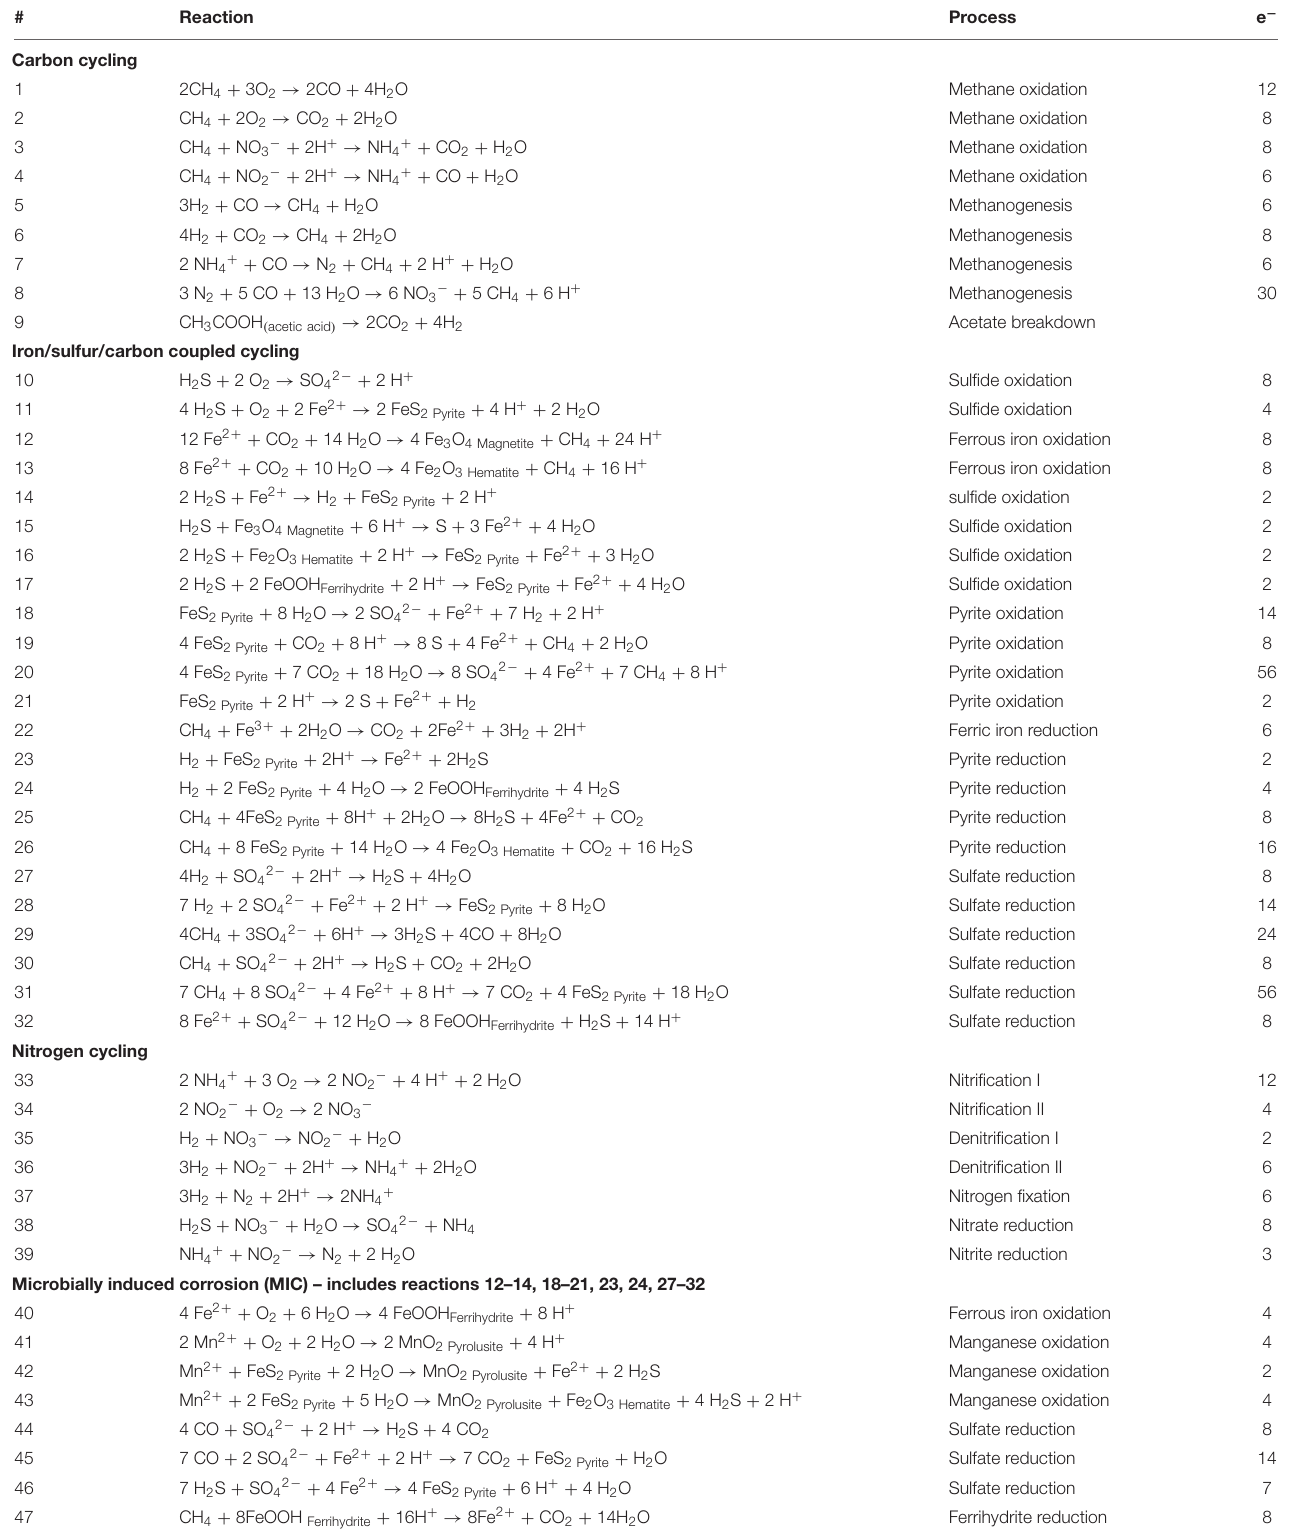
TABLE 1 | Example reactions describing microbial processes in landfill ecosystems. # Reaction